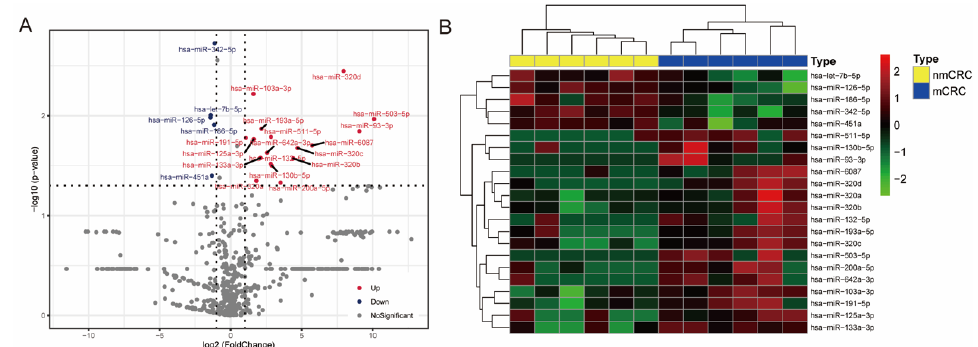
Figure 1. Differential expression of circulating exosomal miRNA among 6 paired nonmetastatic CRC and CRLM plasma specimens. ( A ) Volcano plot of the identified differentially expressed cir- culating exosomal miRNAs, with fold change > 2.0 and p -value < 0.05 considered significant; in the volcano plot, upexpression and downexpression miRNAs are colored in red and blue, respectively. ( B ) Hierarchical clustering of the 22 differential circulating exosomal miRNA expression from 6 patients with nonmetastatic CRC (in yellow) and 6 CRLM patients (in blue). Each row represents an individual miRNA, and each column represents an individual sample. The color shade indicates relative expression levels from low to high on a log2 scale from −2 .0 to 2.0. CRC, colorectal cancer; CRLM, colorectal cancer liver metastases.